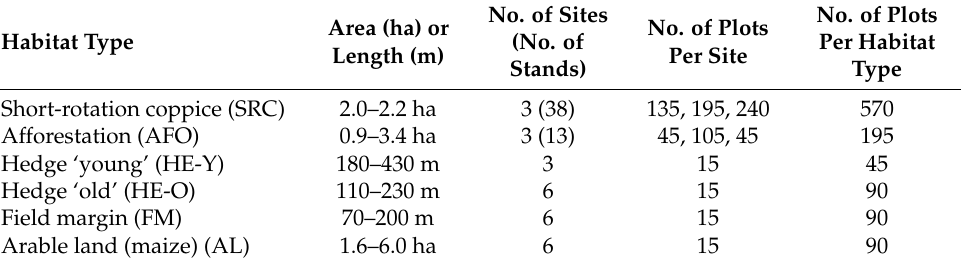
Table 1. Surveyed habitat types and number of surveyed sites, stands and plots per type.